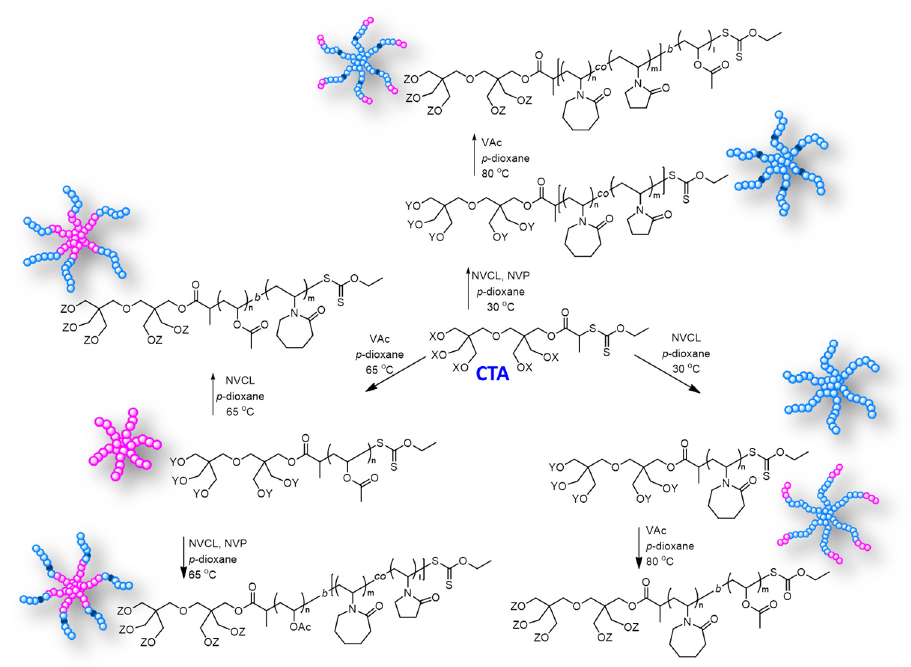
Scheme 1. Synthesis of hexafunctional star polymers and block copolymers based on PNVCL using a multifunctional xanthate as a RAFT agent.